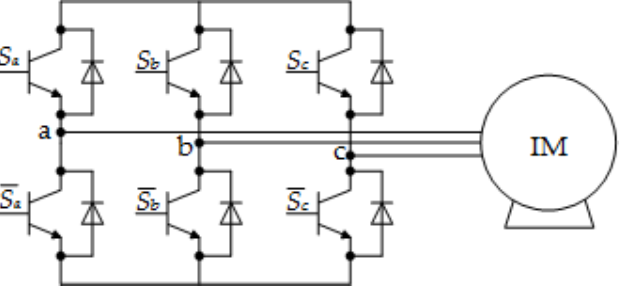
Figure 6. Circuit diagram of a three-phase star-connected induction motor powered from a two-level voltage source inverter [26].